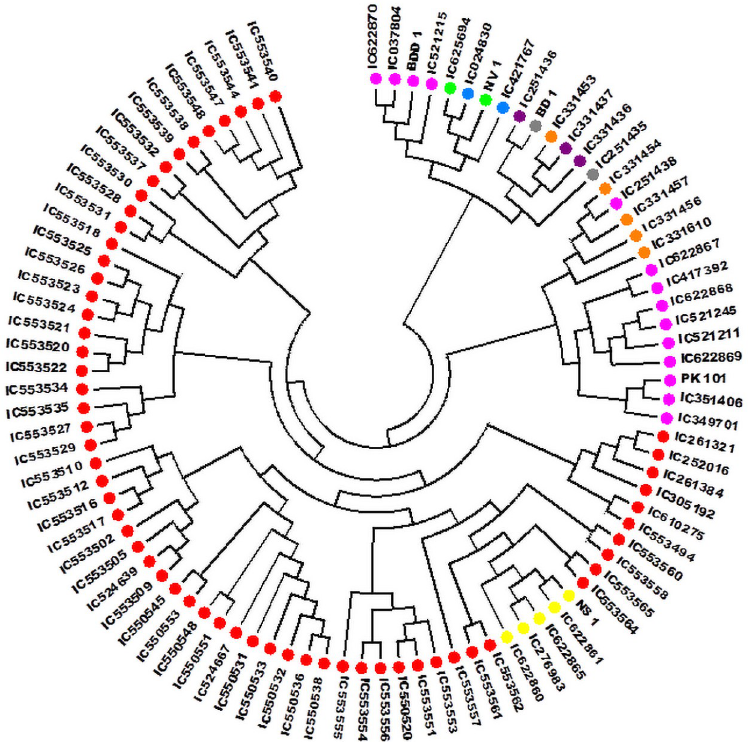
Fig 6. Dendrogram based on nei genetic diversity using Neighbor joining tree method of clustering, depicting genetic diversity and relationship between 94 accessions of V . stipulacea as revealed by polymorphism of 33 SSRs.